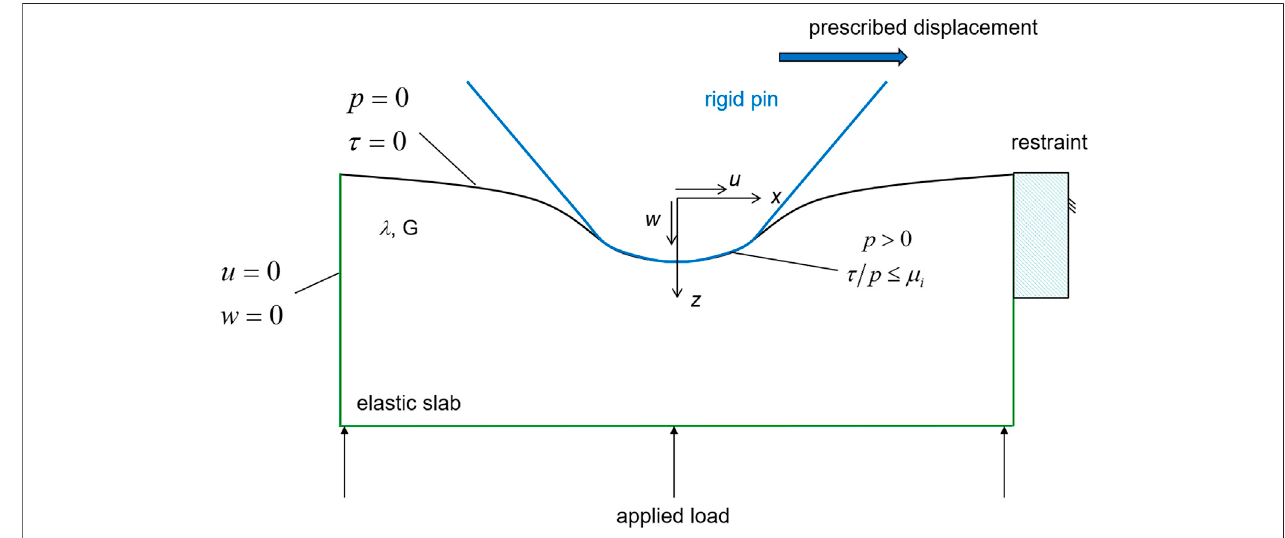
FIGURE 1 | Schematic of the interface under